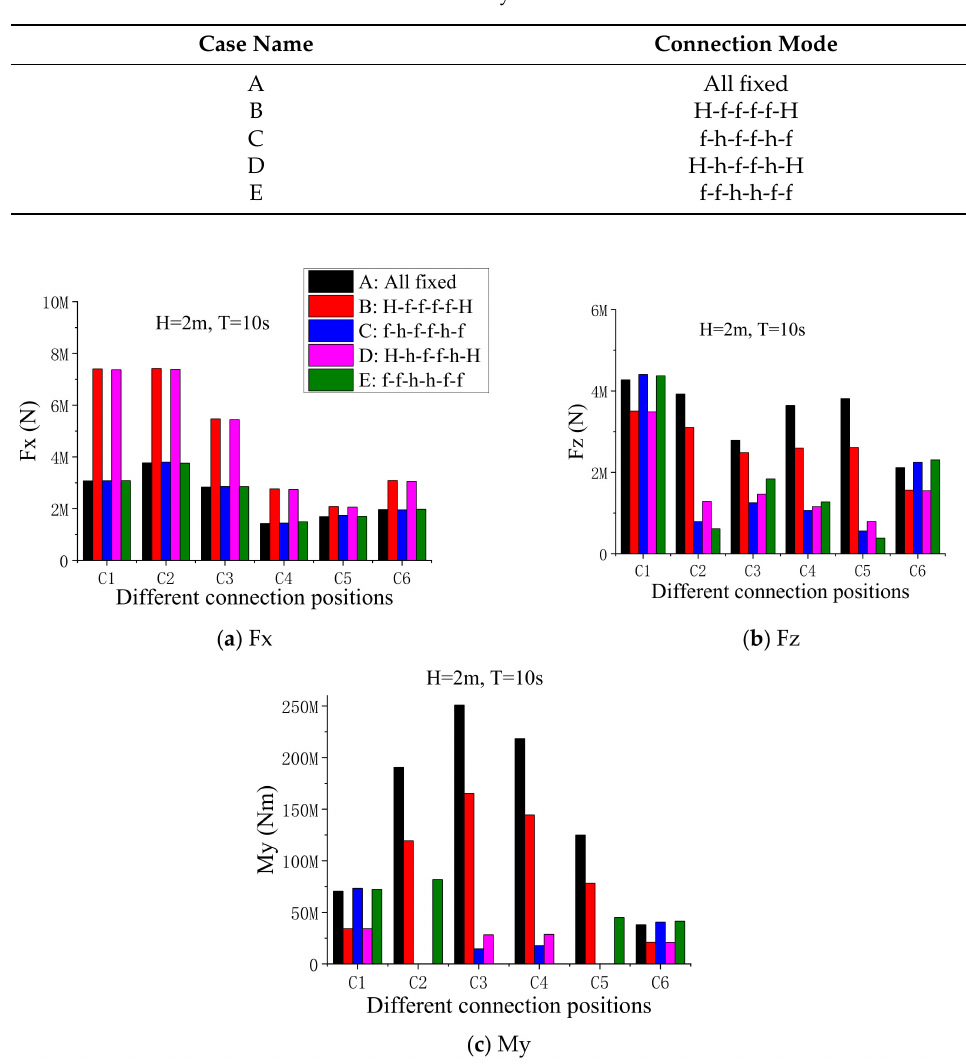
Figure 6. Connector loads of the seven-module MTLPW system with different connection modes: ( a ) Fx, ( b ) Fz, ( c )